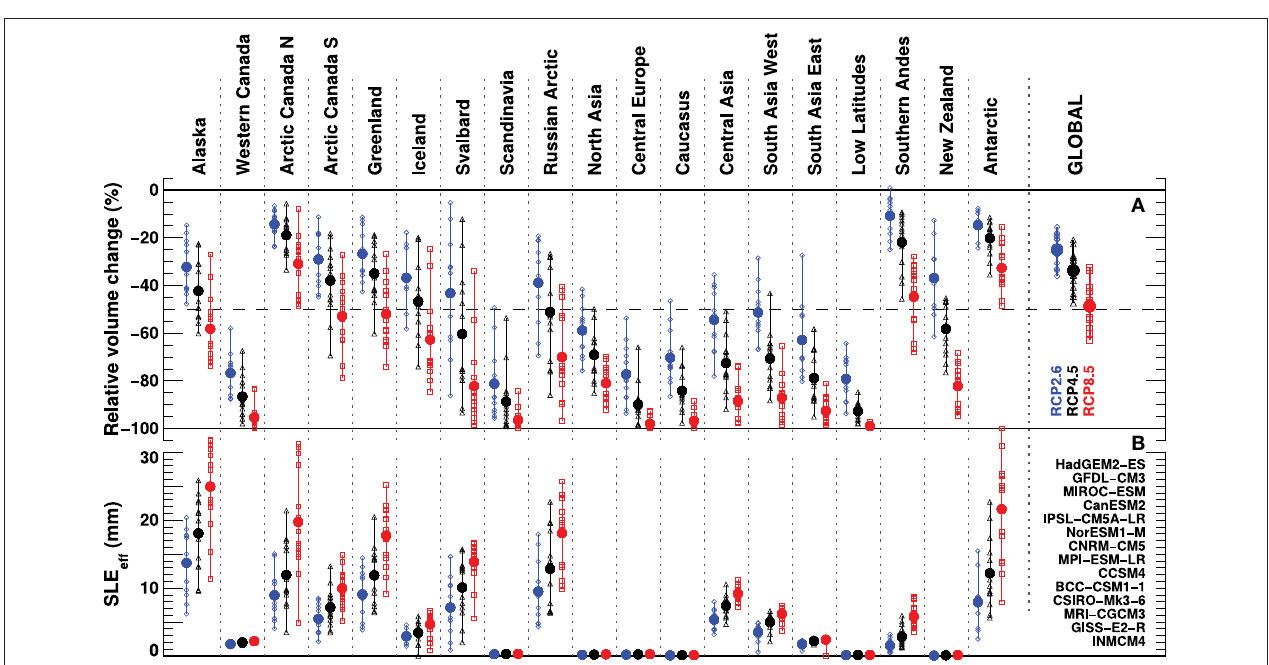
FIGURE 6 | (A) Relative change in regional ice volume and (B) contribution to sea-level rise (SLE eff ) between 2010 and 2100 specified for all 14 GCMs (symbols) and RCP2.6 (blue), RCP4.5 (black), and RCP8.5 (red). The multi-model means are shown as filled circles. GCMs are listed in the order of modeled global SLE eff ( Figure 7 ).